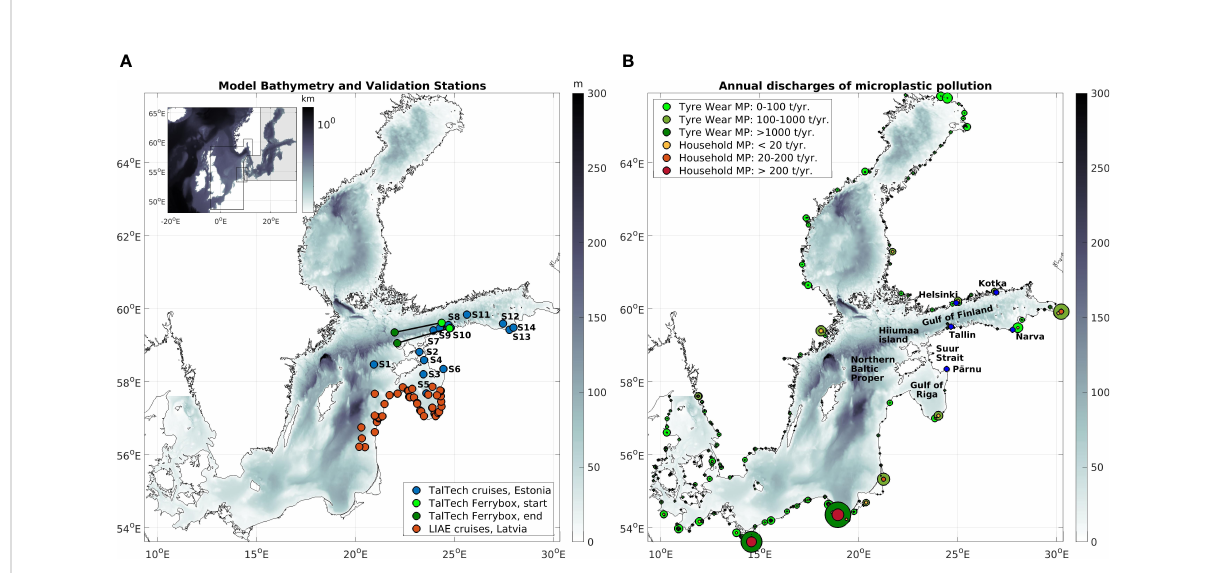
FIGURE 1 Model bathymetry and position of validation stations (A) , as well as annual river discharges of 455 coastal sources in the Baltic Sea (B) : Tire Wear MP1 microplastic loads (green) and household microplastics MP2+MP3 (red) in the units of tonnes per